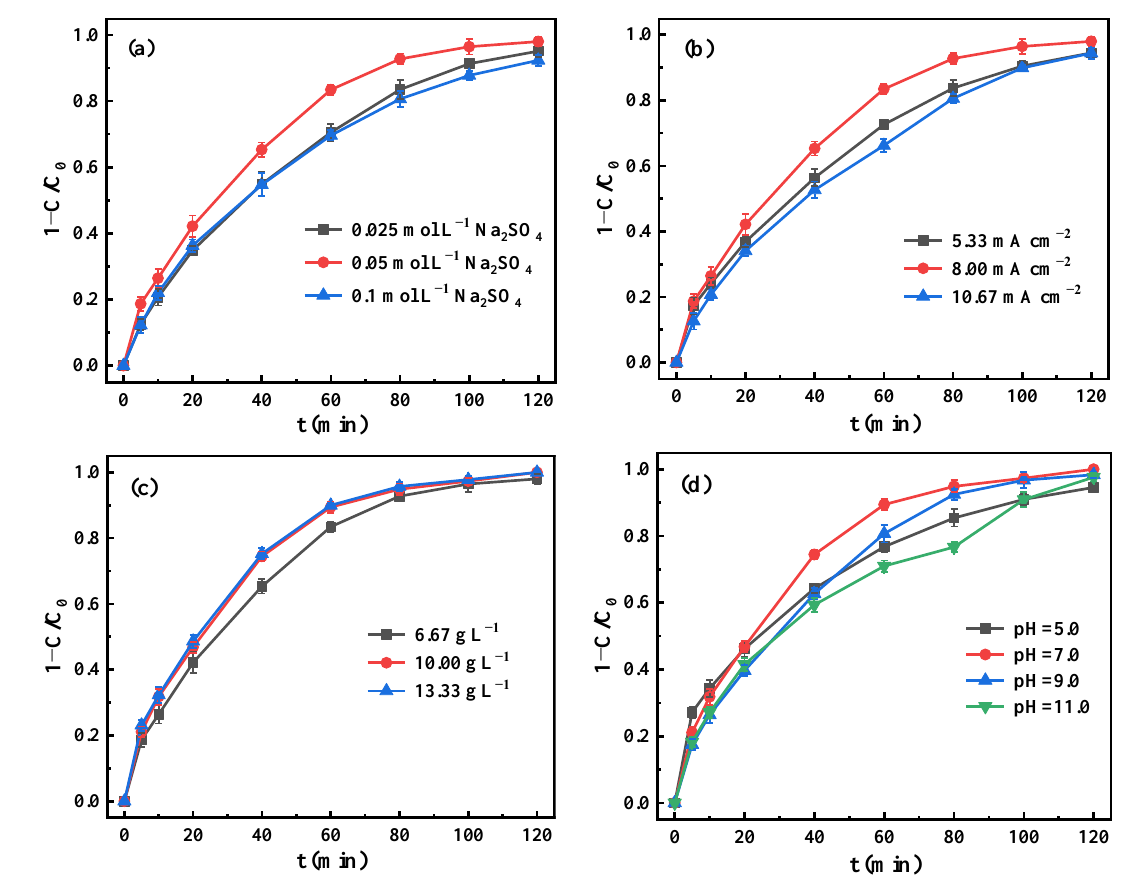
Figure 7. Effect of key parameters on removal efficiency of 15 mg L −1 metronidazole: ( a ) Na 2 SO 4 concentration (current density = 8.00 mA cm −2 , dosage = 6.67 g L −1 , pH = 7.0, air aeration rate = 0.4 L min −1 ); ( b ) current density ([Na 2 SO 4 ] 0 = 0.05 mol L −1 , dosage = 6.67 g L −1 , pH = 7.0, air aeration rate = 0.4 L min −1 ); ( c ) particle electrode dosage ([Na 2 SO 4 ] 0 = 0.05 mol L −1 , current density = 8.00 mA cm −2 , pH = 7.0, air aeration rate = 0.4 L min −1 ); ( d ) solution initial pH ([Na 2 SO 4 ] 0 = 0.05 mol L −1 , current density = 8.00 mA cm −2 , dosage = 10.00 g L −1 , air aeration rate = 0.4 L min −1 ).